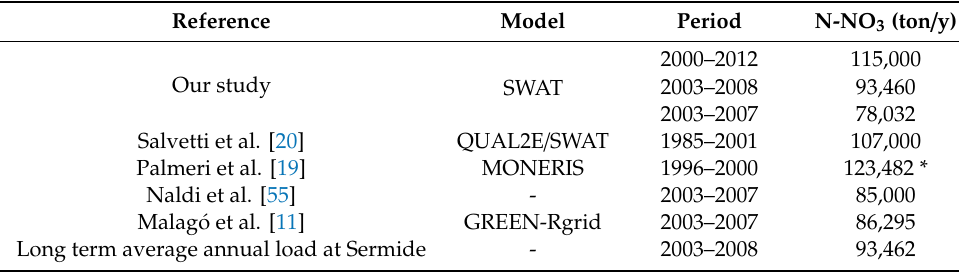
Table 8. Comparison N-NO 3 SWAT annual estimations at Pontelagoscuro with other studies and observations at Sermide, the nearest station to Pontelagoscuro with